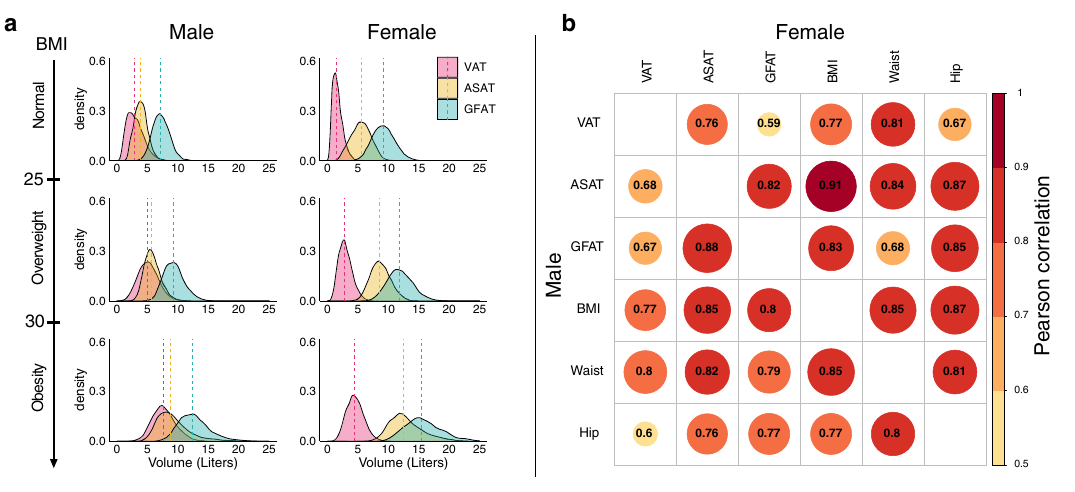
three anthropometric measures: body mass index (BMI), waist circumference (Waist), and hip circumference (Hip). Analogous plots for BMI-adjusted fat depots are shown in Supplementary Figs. 5 – 6. Abbreviations: VAT,visceral adipose tissue; ASAT, abdominal subcutaneous adipose tissue; GFAT, gluteofemoral adipose tis- sue; BMI, body mass index; Waist, waist circumference; Hip, hip